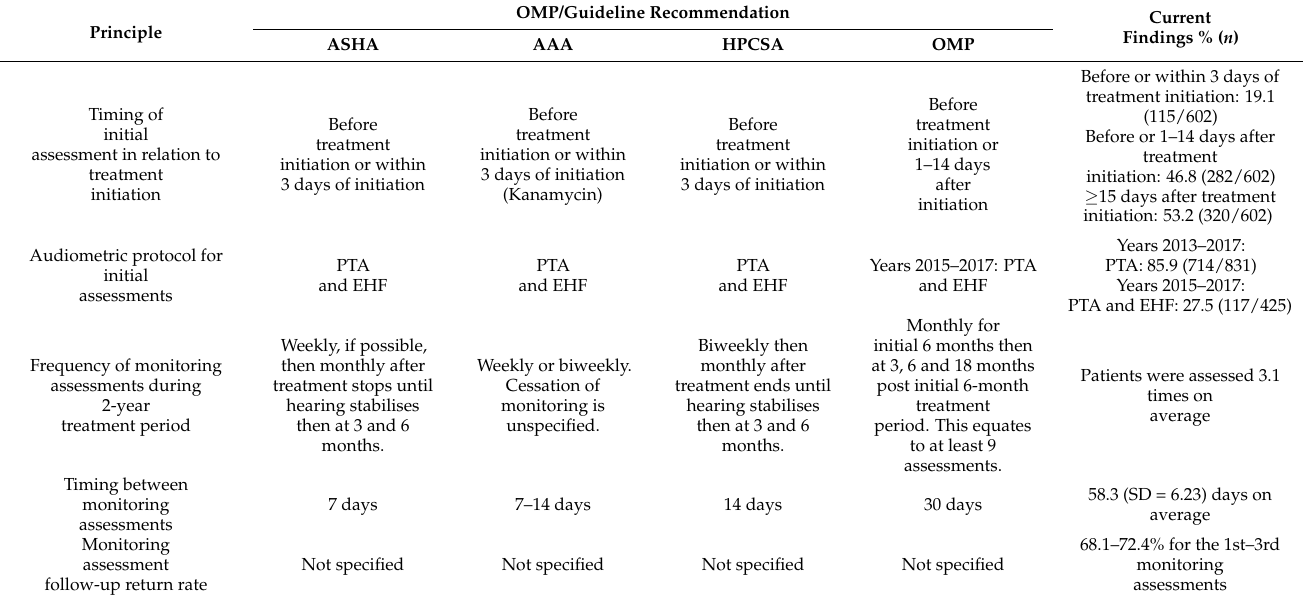
Table 5. Current findings compared to the OMP protocol and guideline recommendations